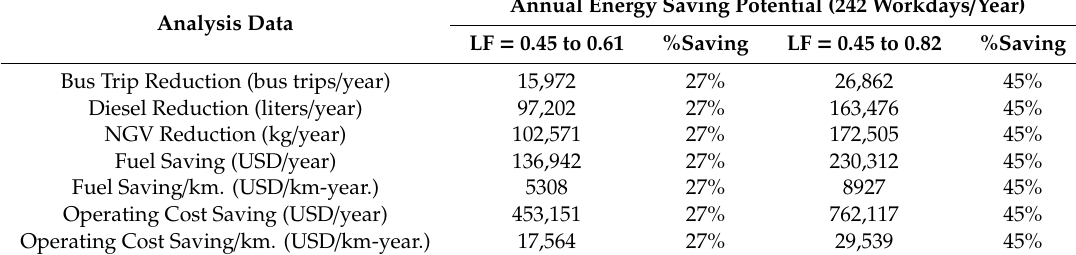
Table 5. Annual Energy Saving Potential after Applied PBRU on Rama 2 Road during the a.m. Peak Period.